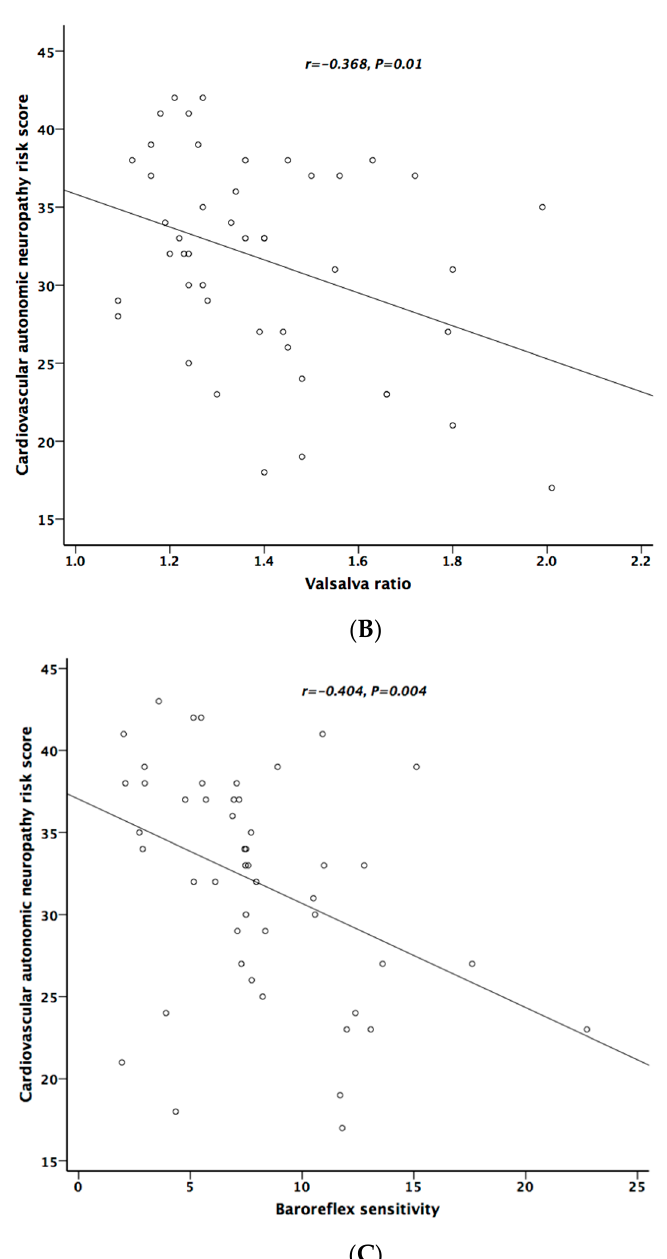
Figure 2. The relationship between cardiovascular autonomic neuropathy (CAN) risk score and heart rate response to deep breathing ( A ), Valsalva ratio ( B ), and baroreflex sensitivity ( C ),